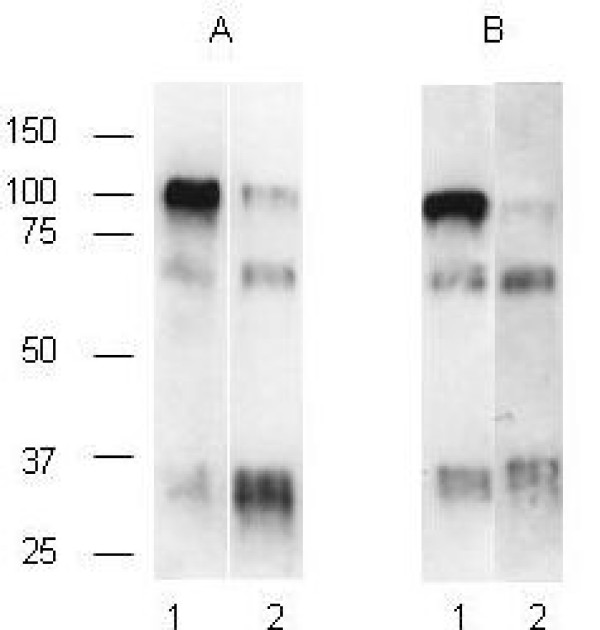
Biochemical characterisation of hZP2 from unfertilised and fertilised oocytes. ZP were isolated from a pool of 3 unfertilised (lane 1) and 3 fertilised (lane2) oocytes recovered after an IVF procedure (A) or a sperm-binding experiment (B) (experiment 1, Table 1). Oocytes were cleared of bound spermatozoa before ZP isolation. ZP proteins were then solubilised in Laemmli buffer and separated by SDS-PAGE in a 7% polyacrylamide gel. Glycoproteins were transferred to a PVDF membrane and ZP2 was detected by incubation with anti-rhZP2 and enhanced chemiluminescence. Molecular masses are indicated on the left.